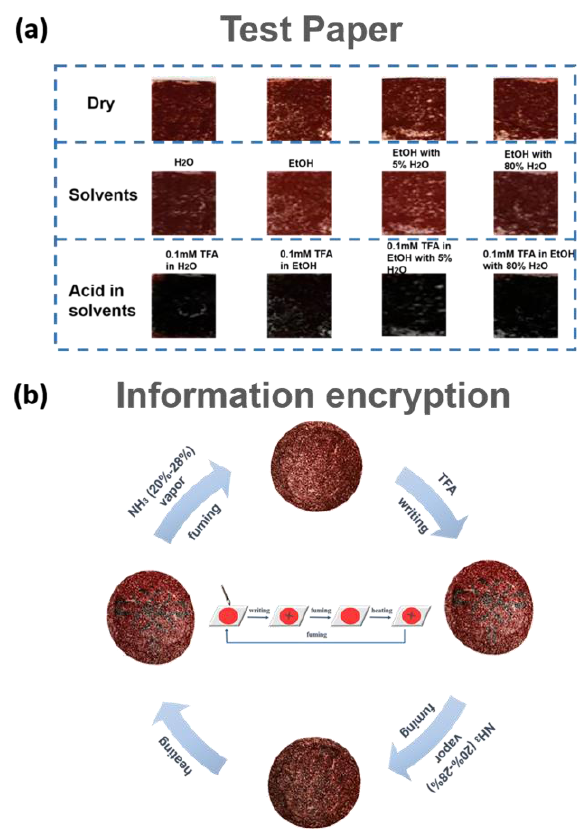
Figure 4. ( a ) Changes in color of TPBD-TA COF-based test paper before and after dropping solvents and acidic solutions, ( b ) visible picture of TPBD-TA COF filter paper through 0.1 mM TFA writing and NH 3 (20 – 28% aqueous solution) vapor